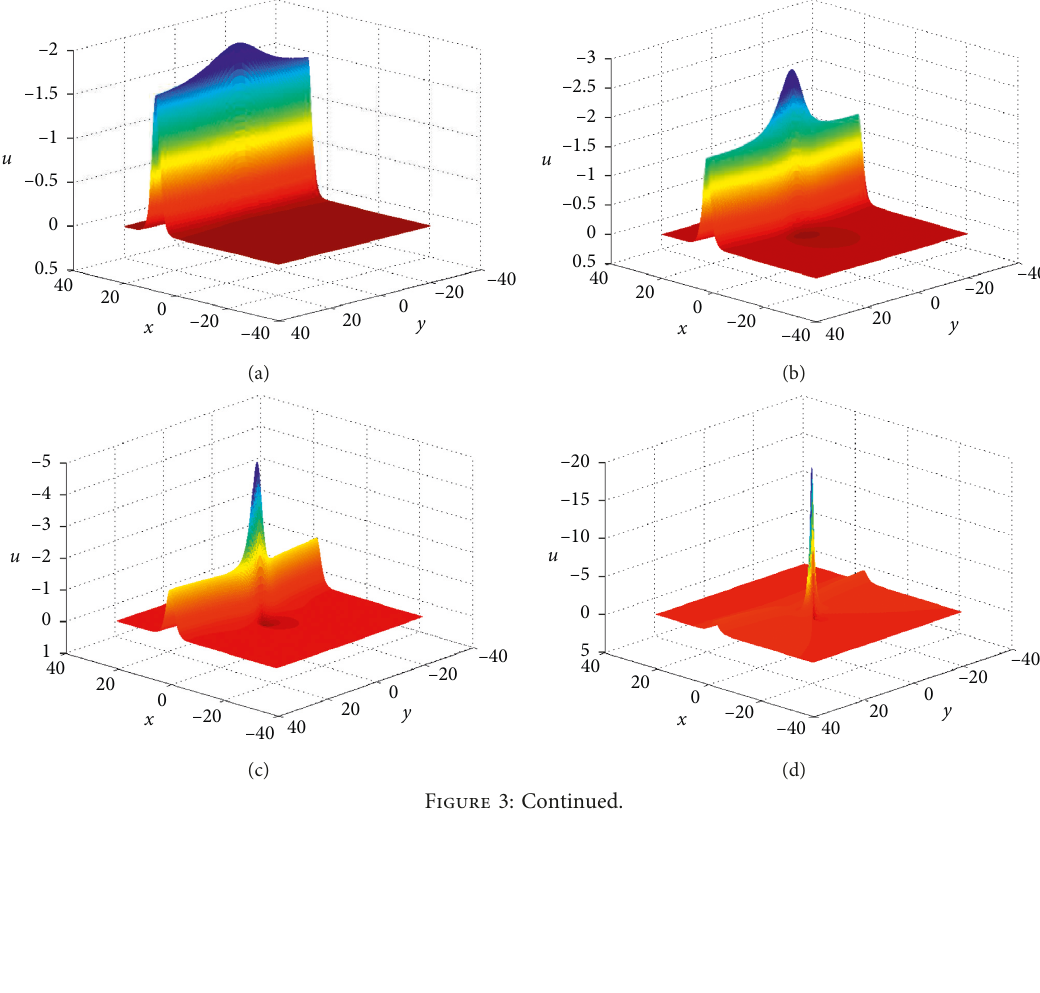
Figure 2: (a) Plots of lump solutions (12) with α map in the ( x , y )